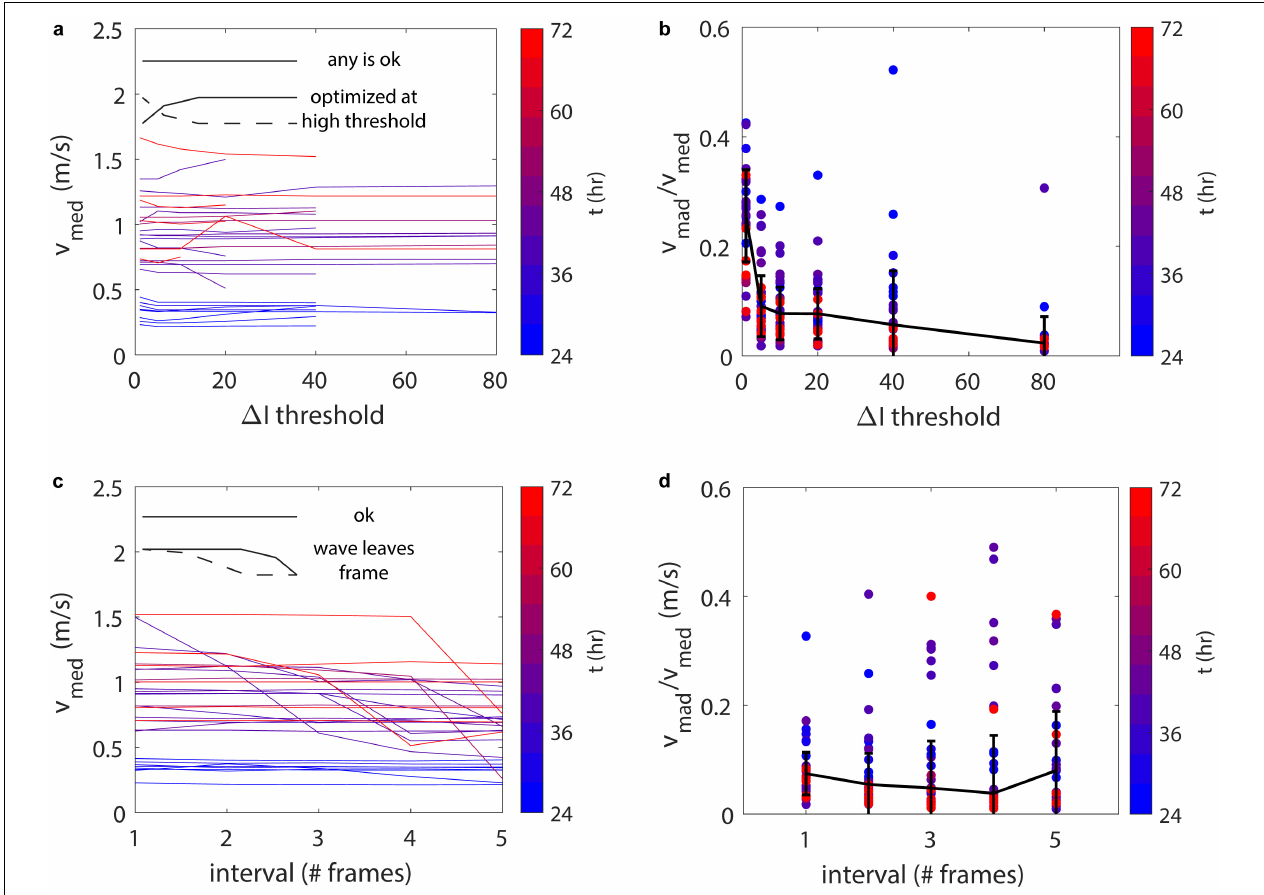
FIGURE 8 | (a) The median velocity measurement of each experiment, v med , shown against (cid:49) I threshold. The color represents the cooling time in hours and each line represents a single experiment. (b) The median absolute deviation of these velocity measurements, v mad , normalized by the median velocity. The black line and error bars respectively indicate the median values and the median absolute deviations of these data points for each (cid:49) I threshold. (c) A similar plot to (a) , against the measurement interval. (d) A similar plot to (b) , against measurement interval. Subfigures (a,b) were done with an interval of 1 and (c,d) with (cid:49) I thresholds indicated in Table 1